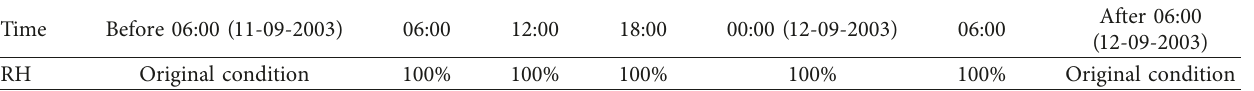
Figure 2: Change in initial and boundary conditions for (a) increase of SAT and SST and (b) maximization of RH. Table 2: Modification of RH in the south boundary